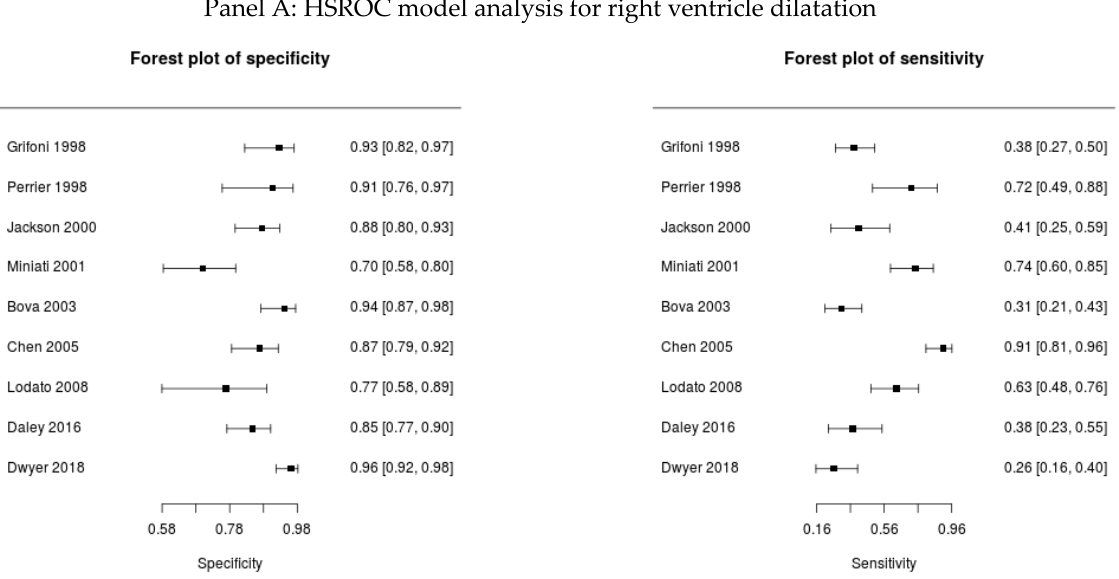
Panel A: HSROC model analysis for right ventricle dilatation